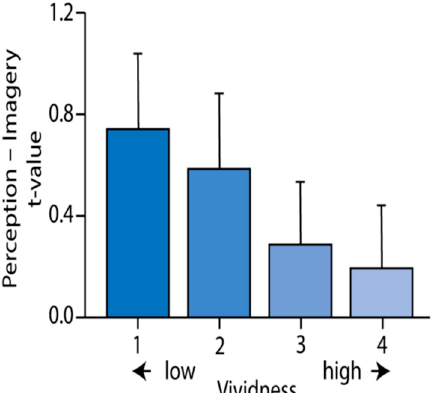
Figure 4. Difference between the effect of perception and the effect of imagery, separately for the four vividness levels. The higher the vividness is, the lower the difference between imagery and perception will be. In each trial, participants were shown two objects successively, followed by a cue indicating which of the two they subsequently should imagine. During imagery, a frame was presented within which subjects were asked to imagine the cued stimulus as vividly as possible. After this, they indicated their experienced vividness on a scale from one to four, where one was low vividness and four was high vividness. The results are shown for a voxel in the early visual cortex that showed the highest overlap between the main e ff ect of perception and the main e ff ect of imagery. More vivid imagery was associated with a smaller di ff erence between perception and imagery [27] (p. 1335). Reproduced from Reference [27] with